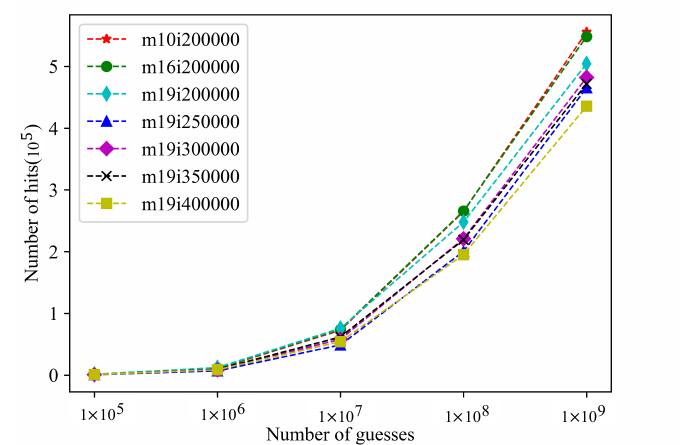
Figure 4. The hits of PassGAN